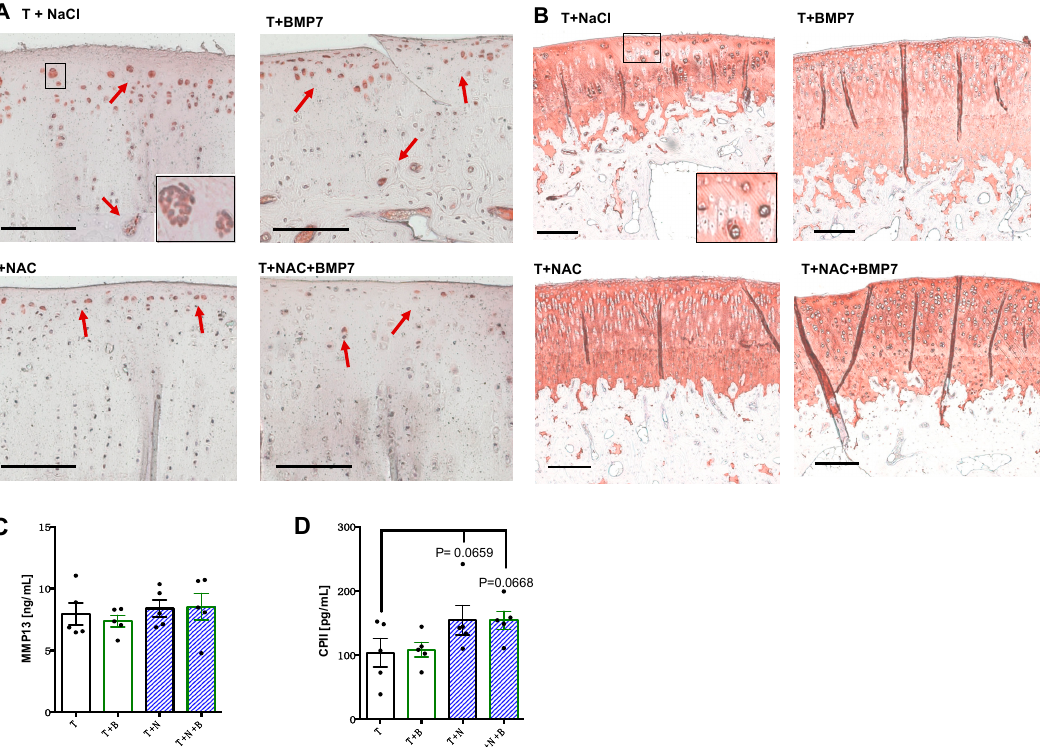
Figure 2. Determination of anabolic and catabolic biomarkers in cartilage and synovial fluid, respectively, after trauma with and without pharmacologic intervention. Femoral condyle sections of rabbits were immunohistochemically stained for ( A ) MMP13 and ( B ) COL2, respectively. The red arrows indicate MMP13-positive cells. The black bar represents 100 µm. Additionally, concentrations of ( C ) MMP-13 and ( D ) CPII were determined in the synovial fluid by means of specific ELISA; data values are charted as scattered plots with bars, n = 5. T = trauma + NaCl, T+B = traumatized and BMP7- treated, T+N = traumatized and NAC-treated, T+N+B = traumatized and BMP7- plus NAC-treated.